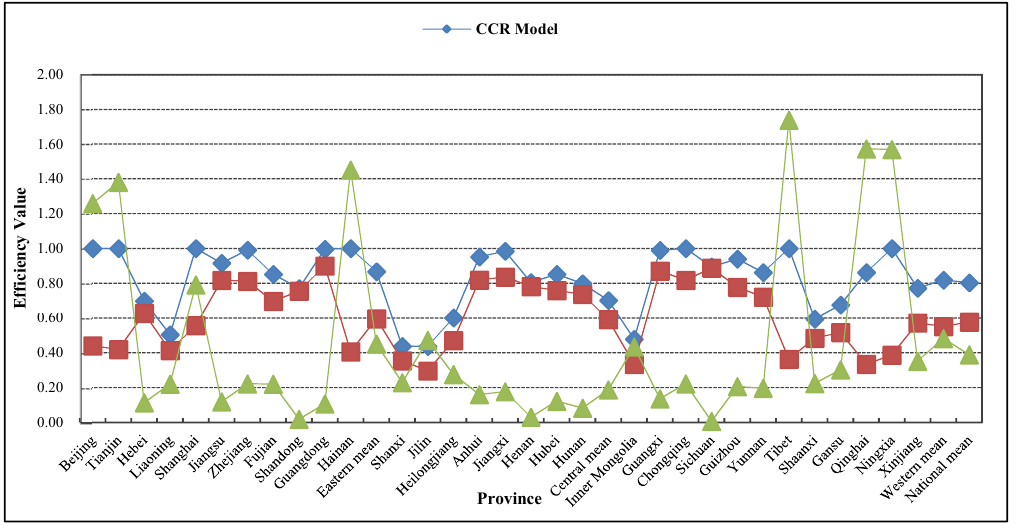
Figure 2. Comparison of allocation efficiency of rural public health resources in each province of China from 2008 to 2017: CCR model and game cross-efficiency model.